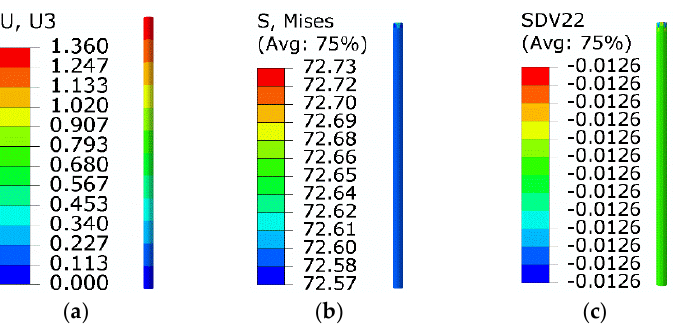
Figure 5. Results of step 3: ( a ) axial displacement; ( b ) equivalent stress; ( c ) volume fraction of M t .